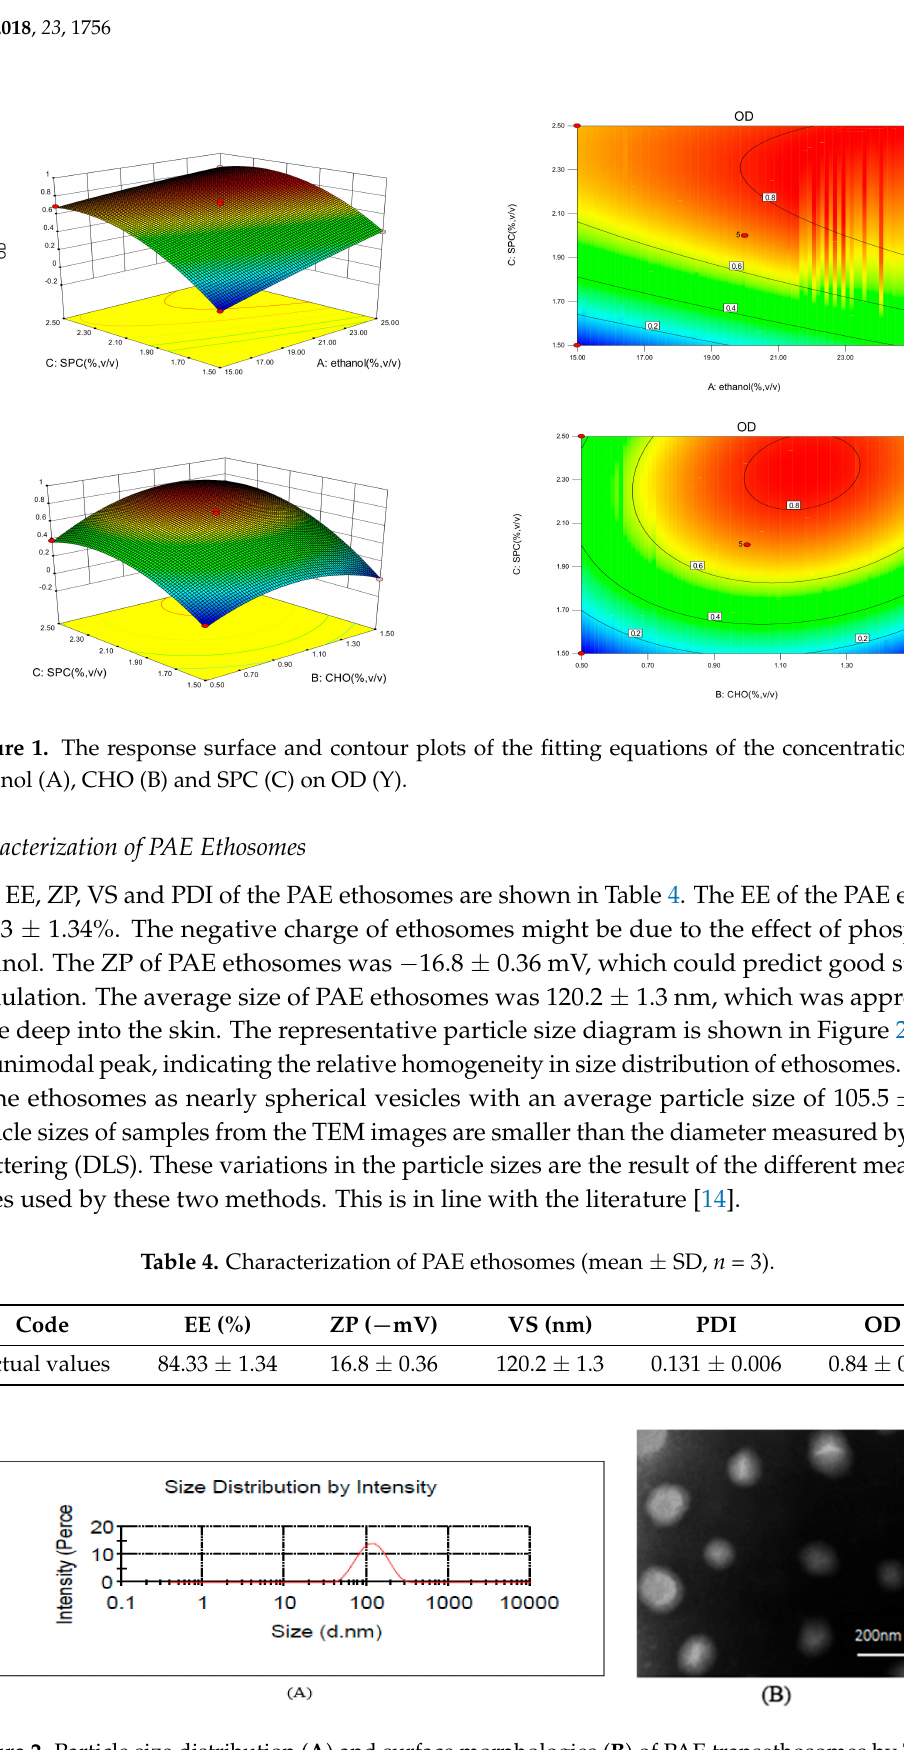
Figure 2. Particle size distribution ( A ) and surface morphologies ( B ) of PAE transethosomes by